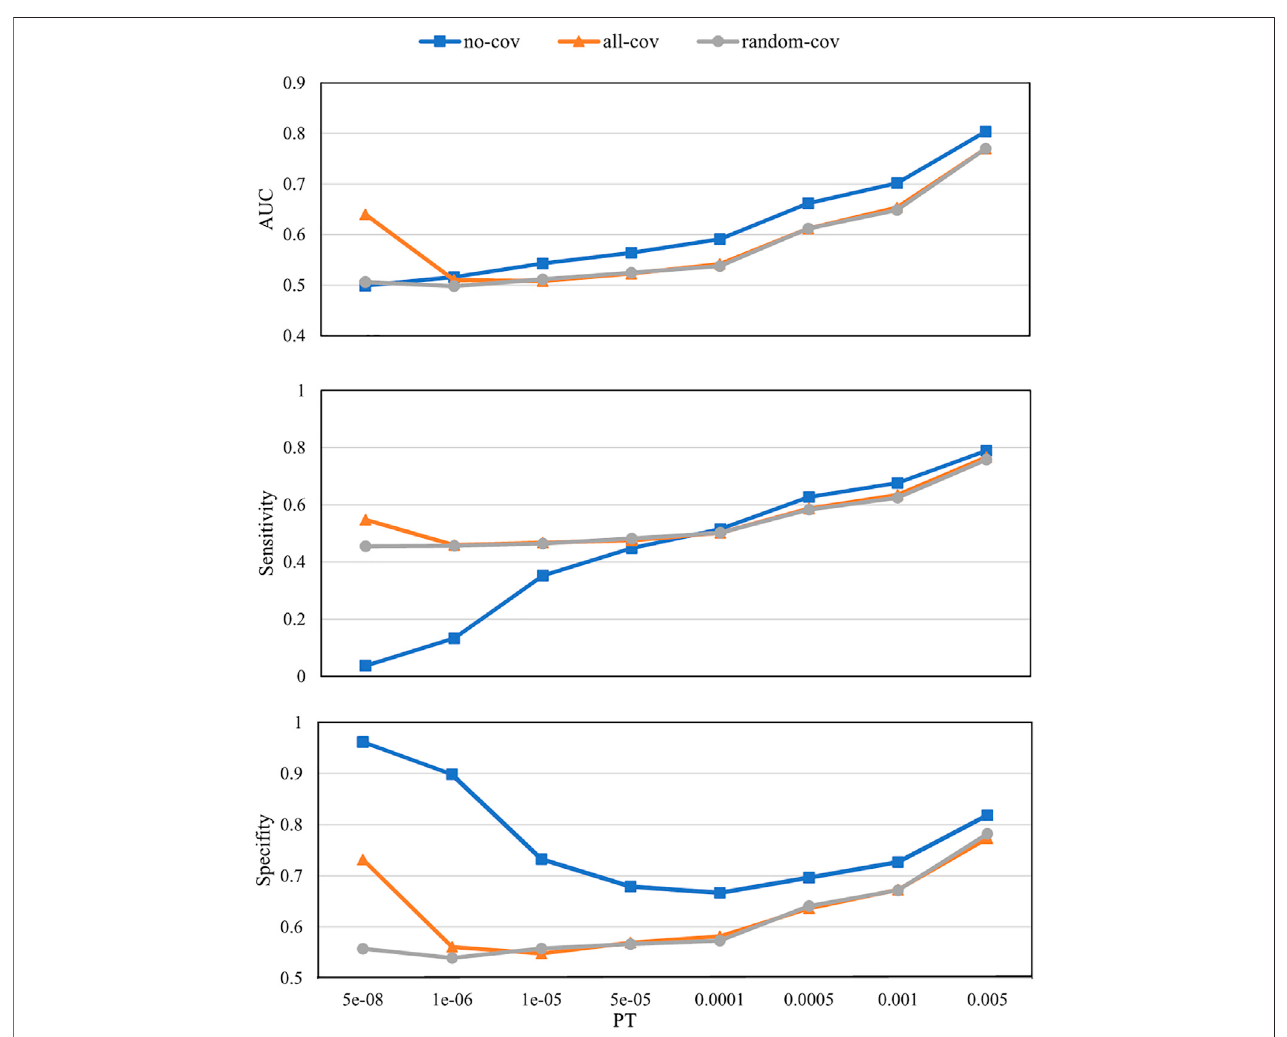
FIGURE 3 | Polygenic risk score (PRS) model prediction results with different p -value thresholds (PTs) under different covariate use strategies. no-cov , no covariates were considered during the training and prediction processes; all-cov , all covariates were considered during the training and prediction processes; random- cov , the PRS model was trained with a sample genetic matrix along with covariates, but made predictions on samples whose covariates were replaced with random numbers. AUC, Area under the receiver operating characteristic curve.